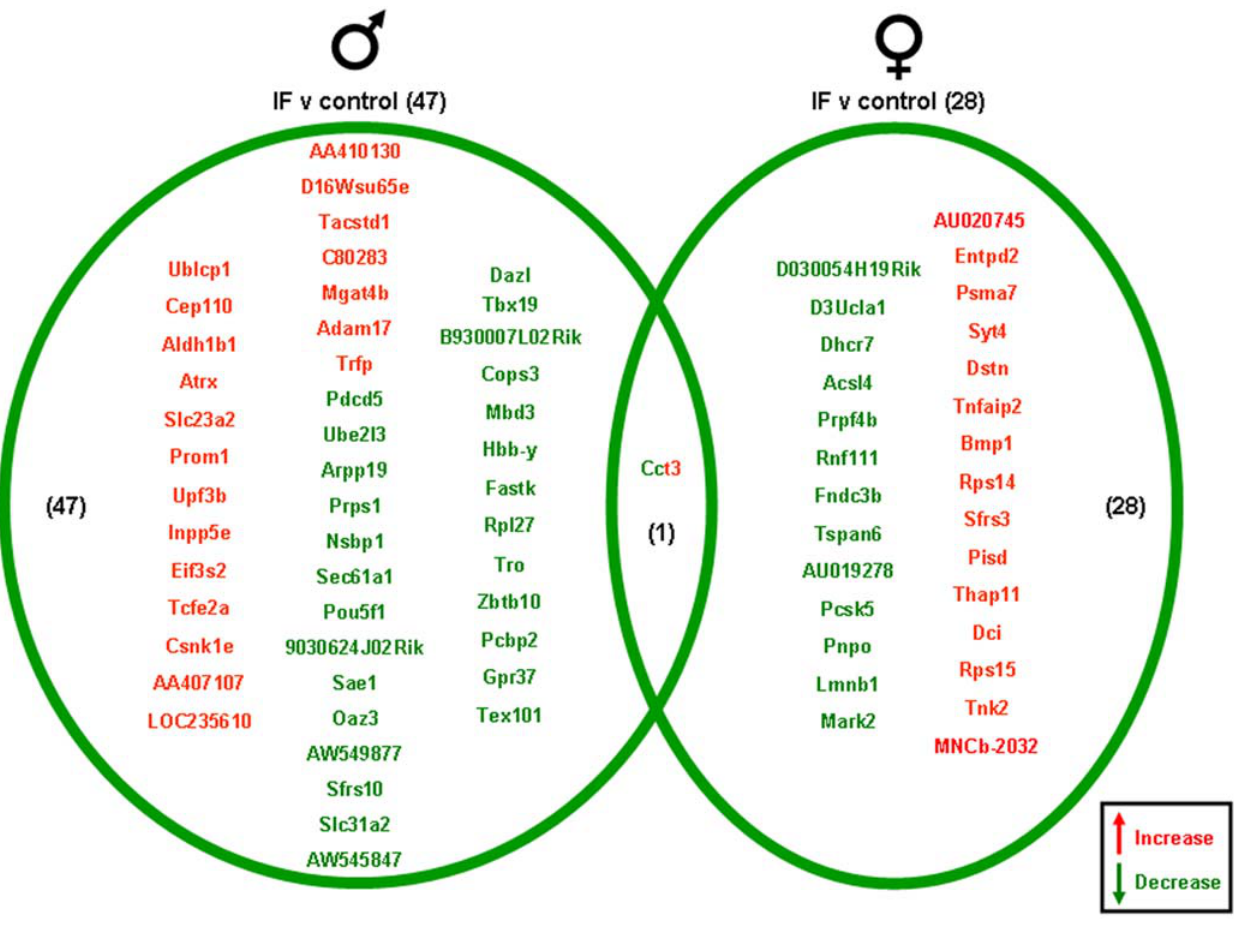
Figure 6. Hippocampi of male and female rats maintained on an IF diet were compared to the hippocampi of rats maintained on a control ( adlibitum ) diet. Genes that were significantly up-regulated (red) or down-regulated (green) were clustered into a Venn diagram. There were 20 significantly up-regulated and 27 significantly down-regulated genes in the hippocampi collected from IF male rats compared to the genes from hippocampi collected from control ( ad libitum ) male rats. Hippocampi collected from IF female rats showed 15 significantly up-regulated (red) and 13 significantly down-regulated (green) genes compared to the hippocampi collected from control ( ad libitum ) female rats. There was one gene that was significantly altered in both the males and females in the IF dietary group compared to the control group. This gene, Cct3, was significantly down-regulated in the IF males and was significantly up-regulated in the IF females, compared to control ( ad libitum ) males and females. Names of the significantly altered genes can be found in Table